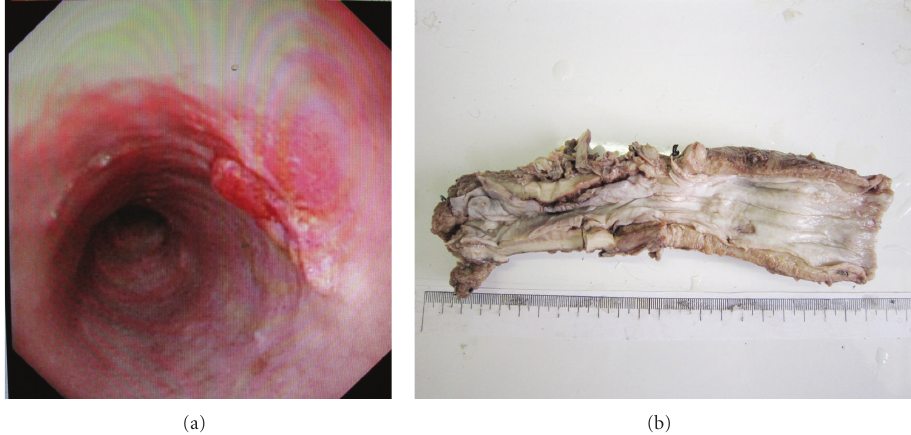
Figure 1: Endoscopic examination and gross presentation. (a) Presence of a white mass in the mucosa. (b) The resected esophagus showed mucosal abnormalities located 1 cm from the proximal margin. The entire esophagus was very hardened and